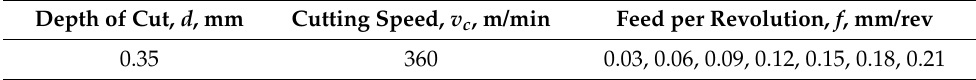
Table 2. Specifications of cutting conditions.